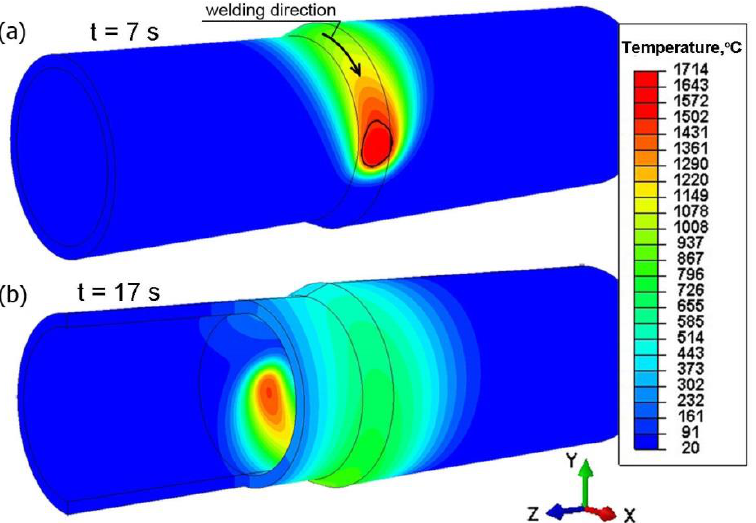
Figure 16. Temperature profile of welded pipes for two simulation times, t = 7 s; t = 17 s.